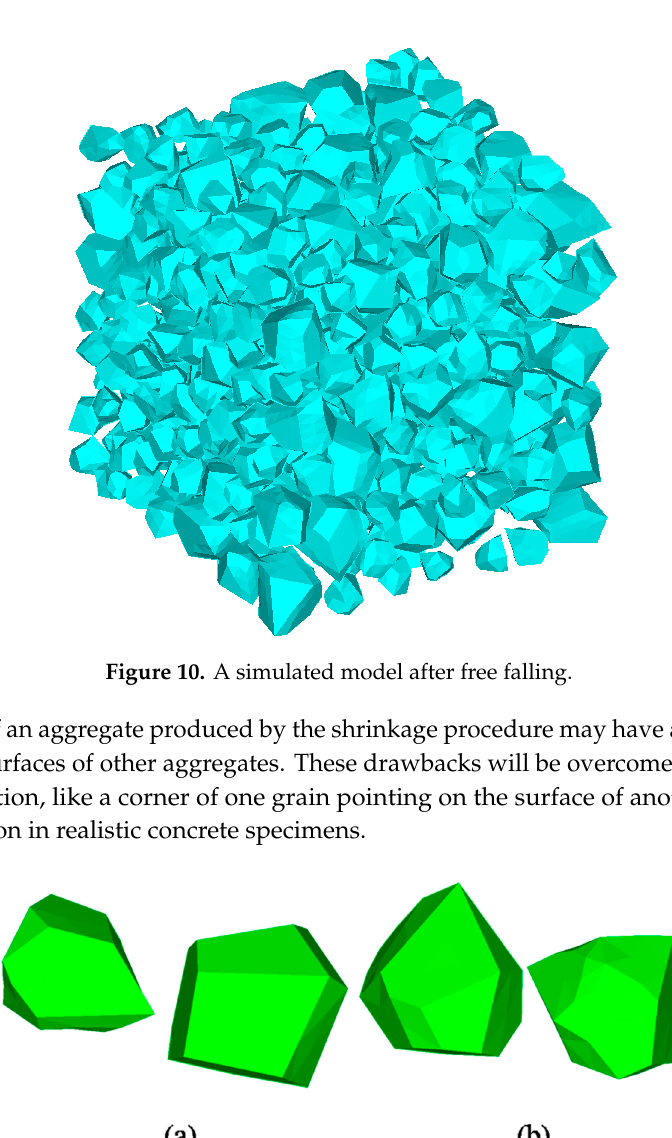
Figure 9. A generated model before free falling.